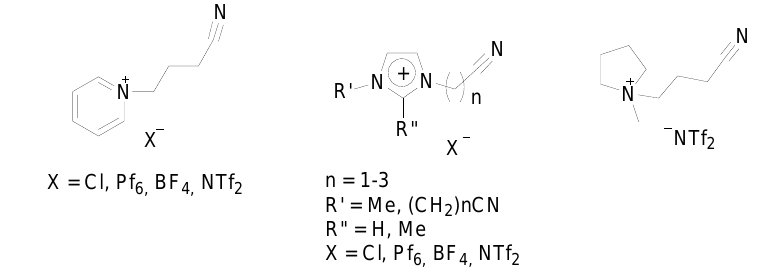
Figure 1. Selected examples of ILs with nitrile-functionality: pyridinium (BCNpy + ; left), Im + ; middle), pyrrolidinium salts (BCN.pyr + ; right) imidazolium (RCN.Im + or (RCN) 2